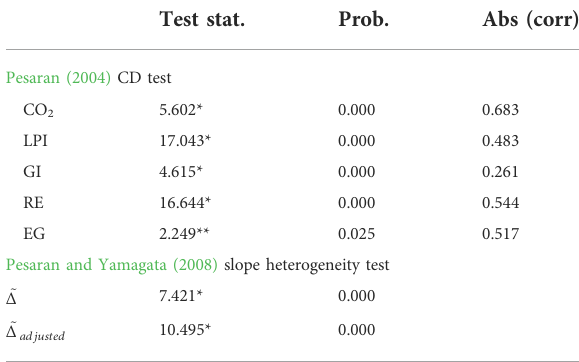
TABLE 4 CD and slope homogeneity test.